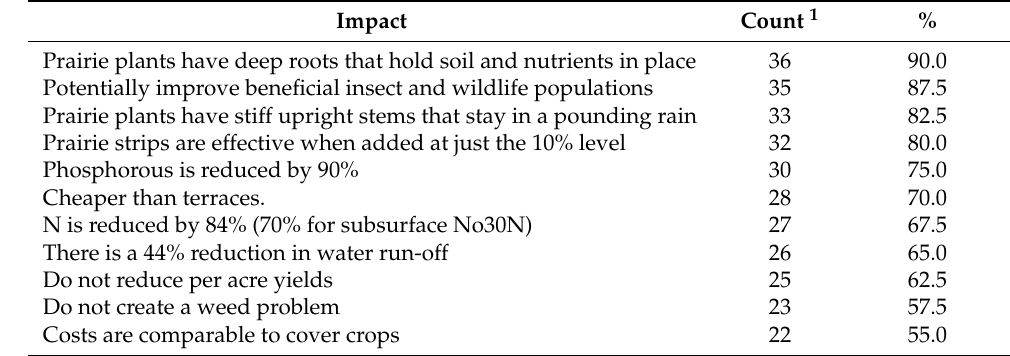
Table 3. Prairie strips impacts on ecosystem services addressed during workshop. Which impacts of prairie strips were convincingly addressed in the workshop?